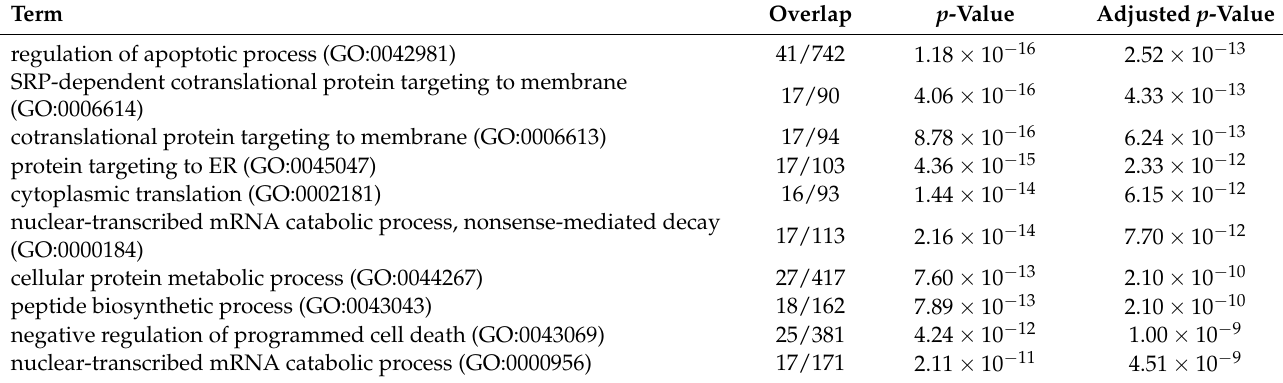
Table 2. The top 10 enriched terms in “GO Biological Process 2021” using Enrichr. Overlap is the number of common genes between the genes uploaded and the genes in the category divided by the number of genes in the category. Probes, whose associated genes were uploaded to Enrichr, were identified using PCA-based unsupervised FE.